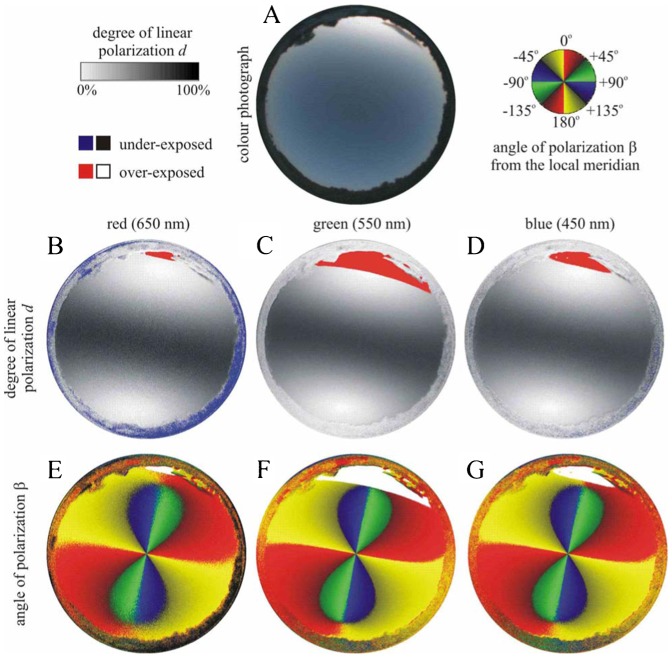
As Fig. 4 for the clear sky no. 402